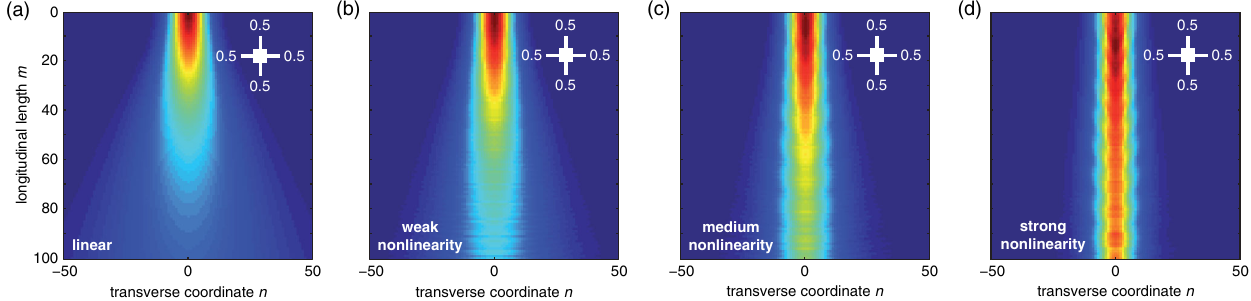
FIG. 11. Nonlinear light propagation in the unperturbed mesh. Panels (a) – (d) show the numerical outcomes with increasing focusing nonlinearity of the Kerr type from left to right. The diffraction of the initial Gaussian beam profile is progressively compensated for, up to a point where the profile comes close to that of a soliton being localized in the central region.